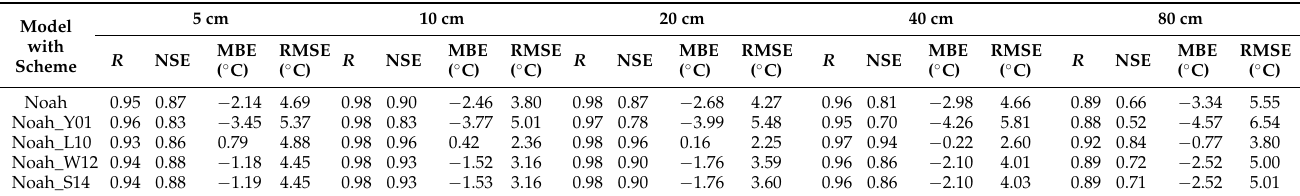
Table 4. Coefficients of correlation (R), model efficiency index (NSE), mean bias error (MBE), and root mean square error (RMSE) between observation and simulation of soil temperatures at five different depths. 5 Model with Scheme